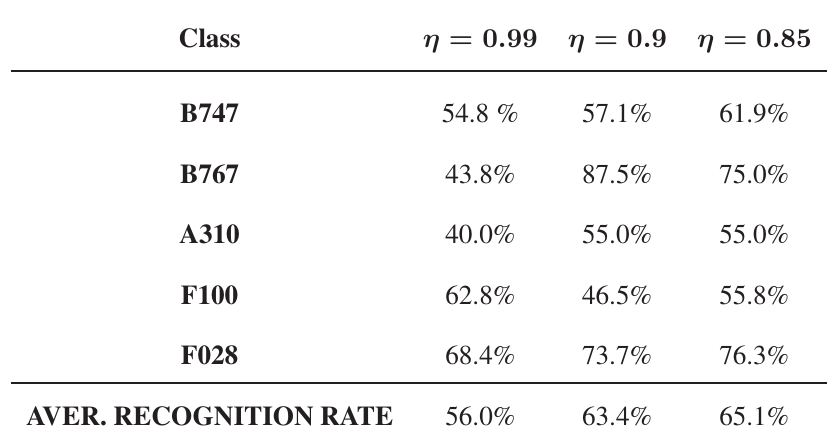
Table 1. Average recognition rates with F 1